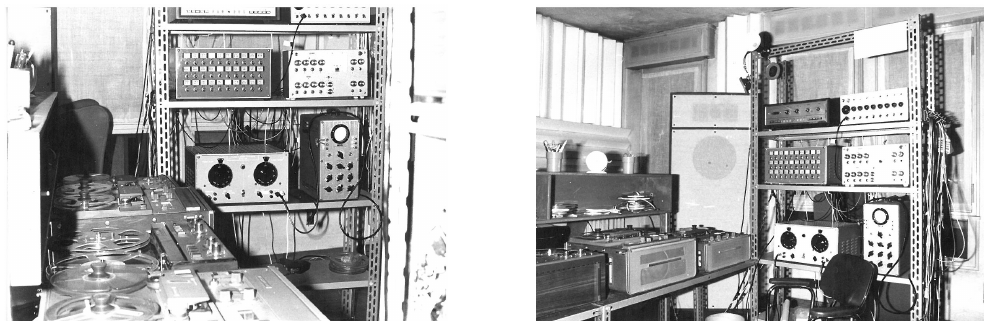
Figure 1. The analog studio Nuove Proposte Sonore (NPS) for electroacoustic-music in Padova, where some components of CSC initiated their